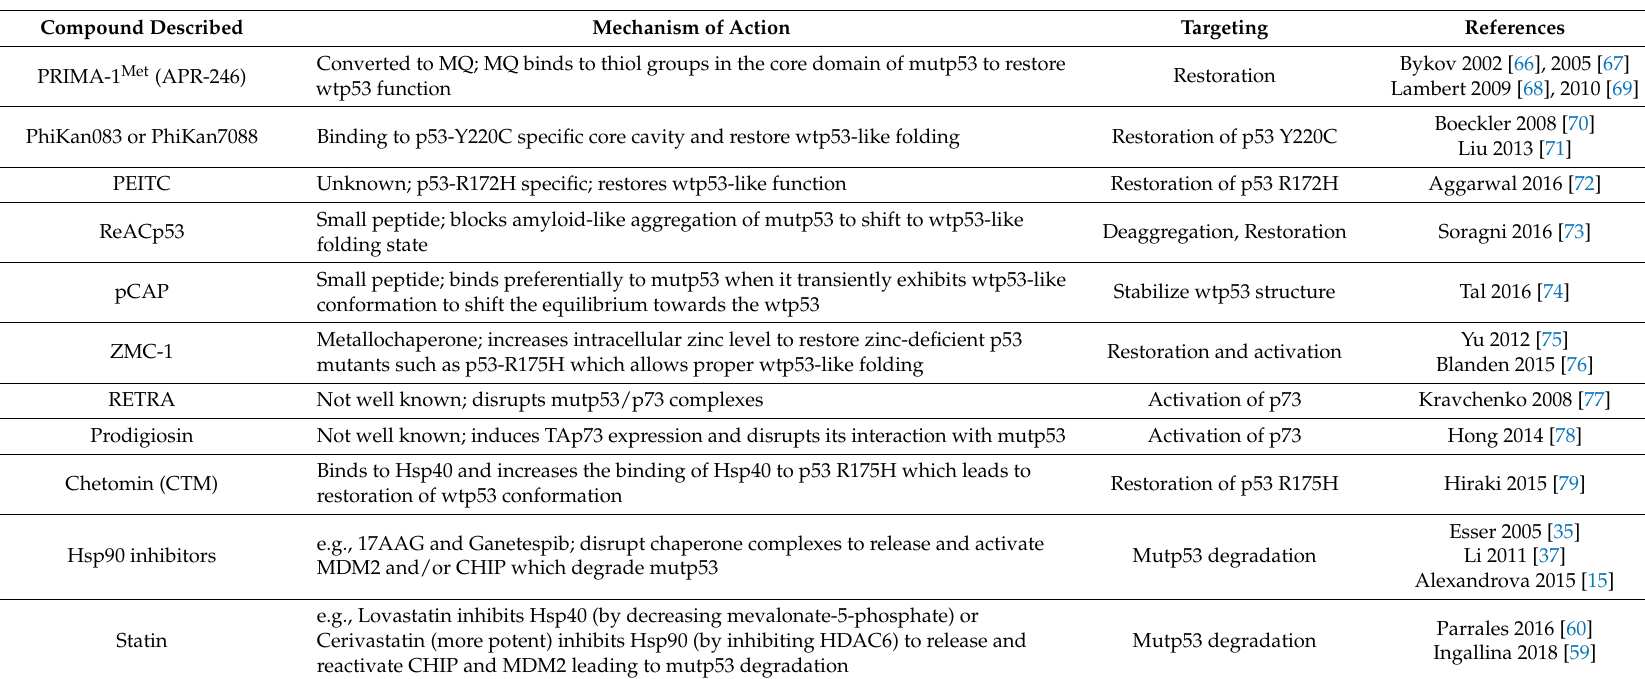
Table 1. Compounds targeting mutant